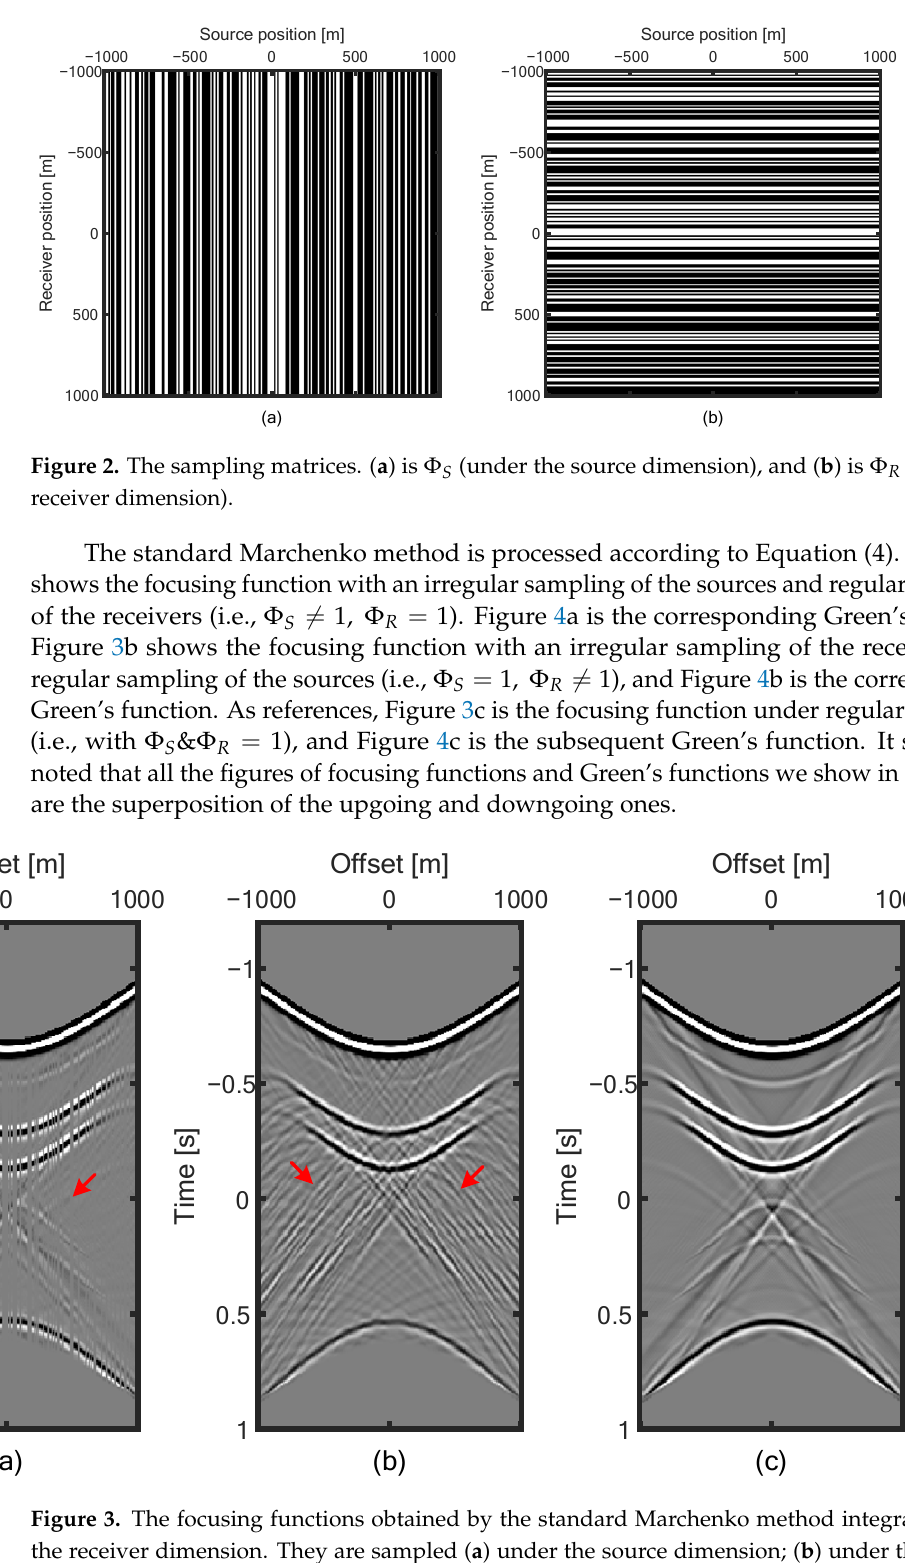
Figure 1. The velocity model. The black star indicates the position of the focal point at (x, z) = (0 m, 950 m).